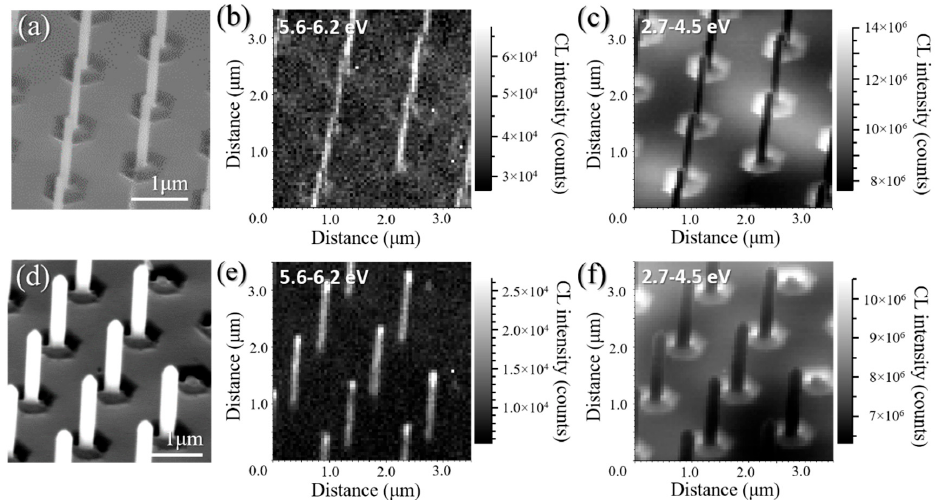
Figure 8. ( a ) Tilted SEM image of the AlN nanorod array after the two-step dry-wet etching process and related CL intensity map extracted between ( b ) 5.6–6.2 eV for the AlN NBE and ( c ) 2.37–4.5 eV for the defect band; ( d ) Tilted SEM image of the AlN nanorod array after 45 min AlN facet recovery and related CL intensity map extracted between ( e ) 5.6–6.2 eV for the AlN NBE and ( f ) 2.37–4.5 eV for the defect